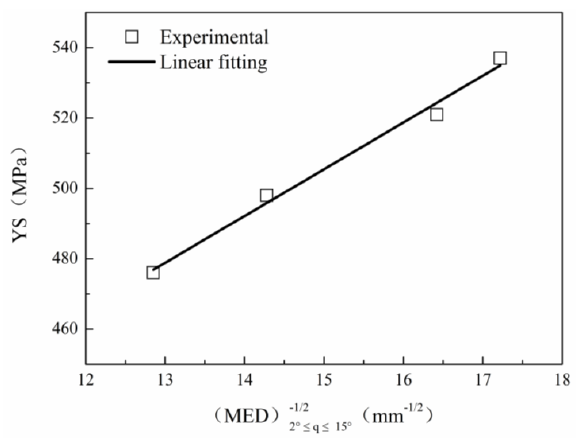
Figure 11. YS of samples with different nitrogen contents as a function of the reciprocal square root of QPF + GBF effective grain size, MED 2° ≤ θ ≤ 15° . YS —yield strength, MED—misorientation equivalent diameter, PF—quasi-polygonal ferrite and GBF—granular bainitic ferrite.